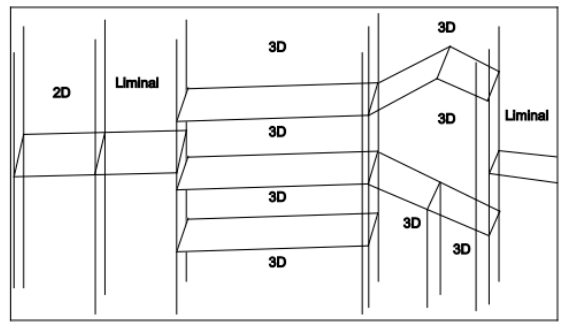
Figure 11. Mixed use of boundary face strings and boundary faces defining both bounded and unbounded 3D volumes: Annex B in [38].